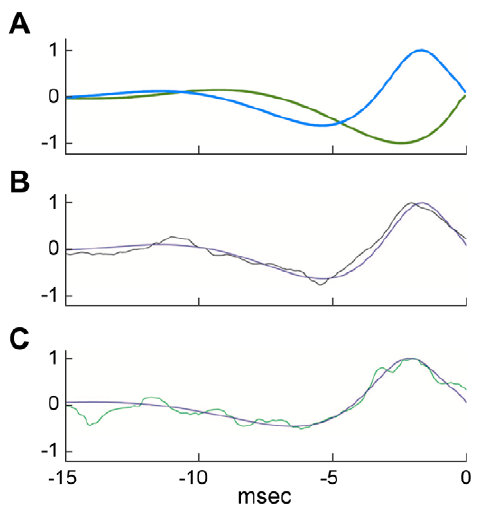
Figure 5. Comparison of optimal signals obtained from calculus of variation and noise analysis. A ) Calculus of variation waveforms determined from an optimization of the V , m , n , and h values at the end of the depolarizing (blue curve) and hyperpolarizing (green curve) pulses used to elicit a spike in the Hodgkin & Huxley model (Figure 2B & C, respectively) as described in the text (Results and Methods). These results were normalized relative to the maximum value of the blue curve. The RMS current of the blue curve is 38% less than that of the green curve. B ) Overlap of the blue curve in A with the optimal noise trace obtained from the analysis of Figure 3. C ) Comparison of another one of the results from Figure 4 with the optimal calculus of variations stimulus determined from a revised version of the Hodgkin & Huxley equations [14].